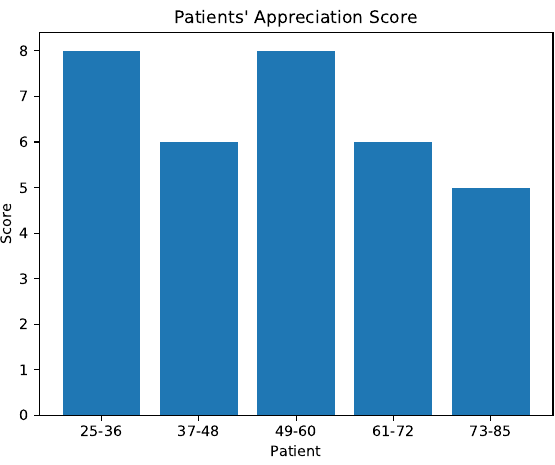
Figure 17. Appreciation score provided by the